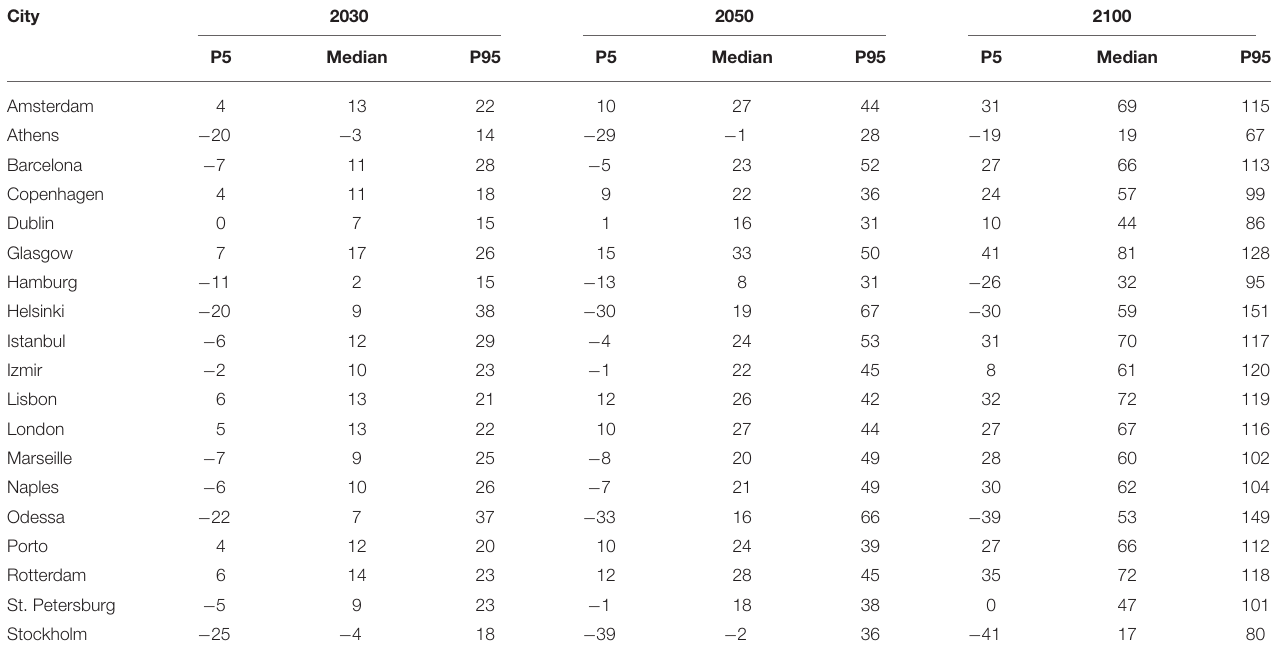
TABLE 1 | Future sea-level rise projections for each city under RCP8.5, measured in cm. Source: Kopp et al. (2014). City